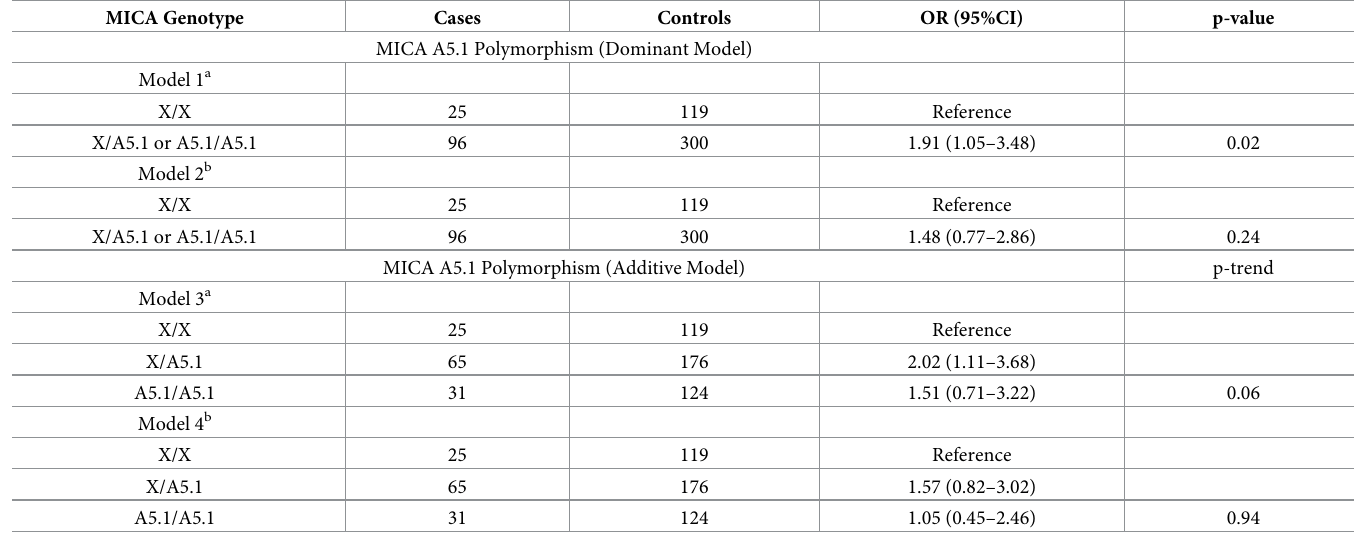
Table 3. Association between the genotype distribution of the MICA A5.1 polymorphism (dominant and additive models) and pancreatic cancer risk. MICA